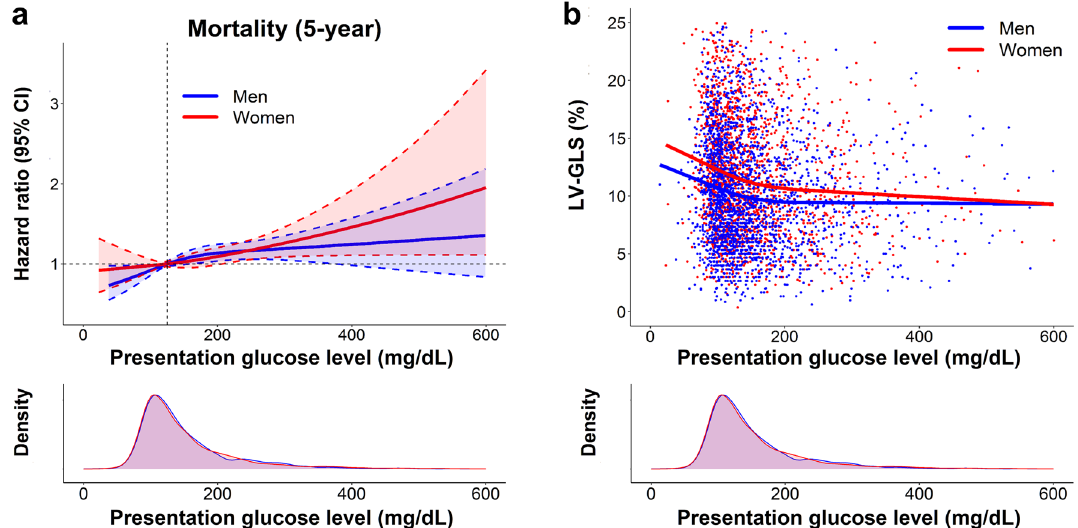
Figure 3. Sex-specific association of presentation glucose level with mortality risk and LV-GLS. ( a ) The graph shows the adjusted hazard ratios (solid lines) and 95% confidence intervals (dashed lines and shaded area) for the association between presentation glucose level and 5-year mortality in men (blue) and women (red). The glucose level was modeled with RCS in Cox models. The reference of glucose level was set at 125 mg/dL for hazard ratios estimation. Density plots show the distribution of patients according to the glucose level. ( b ) RCS curves were plotted between presentation glucose level and LV-GLS. Each dot indicates an individual patient’s data. LV-GLS = left ventricular global longitudinal strain, RCS = restricted cubic